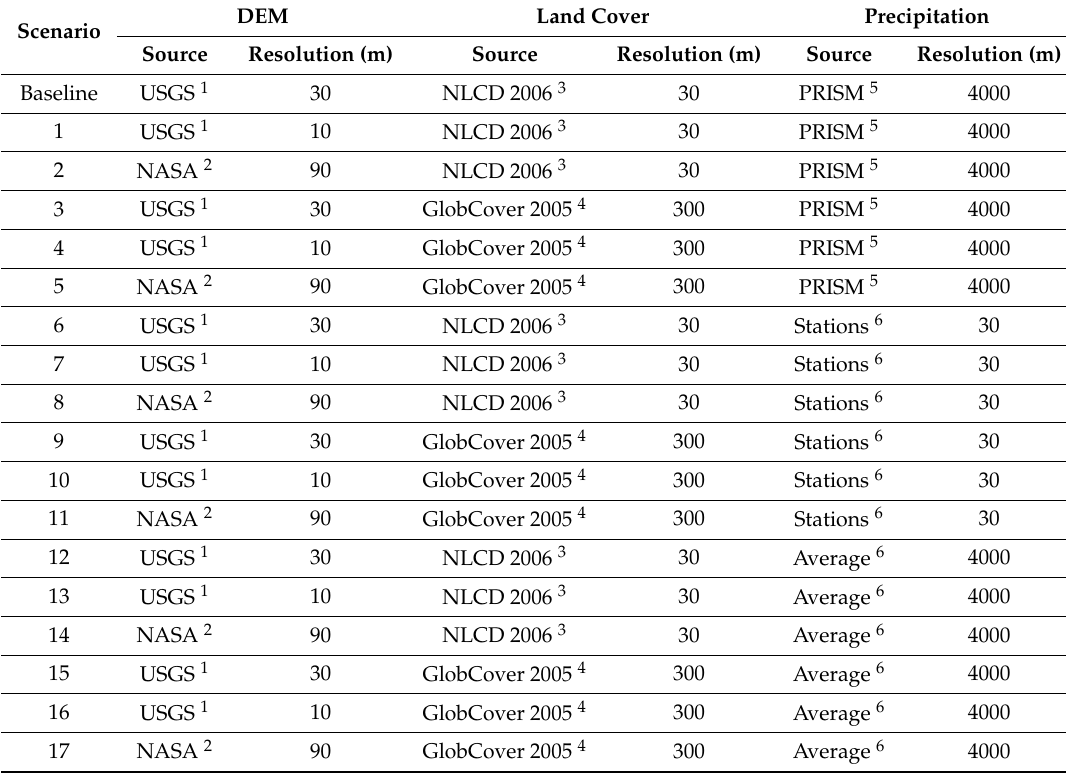
Table 3. Scenarios used in this study are a unique combination of input spatial data of the Nutrient Delivery Ratio (NDR) model. Digital elevation models (DEM), land cover datasets, and precipitation grids used are displayed with their respective data source and spatial